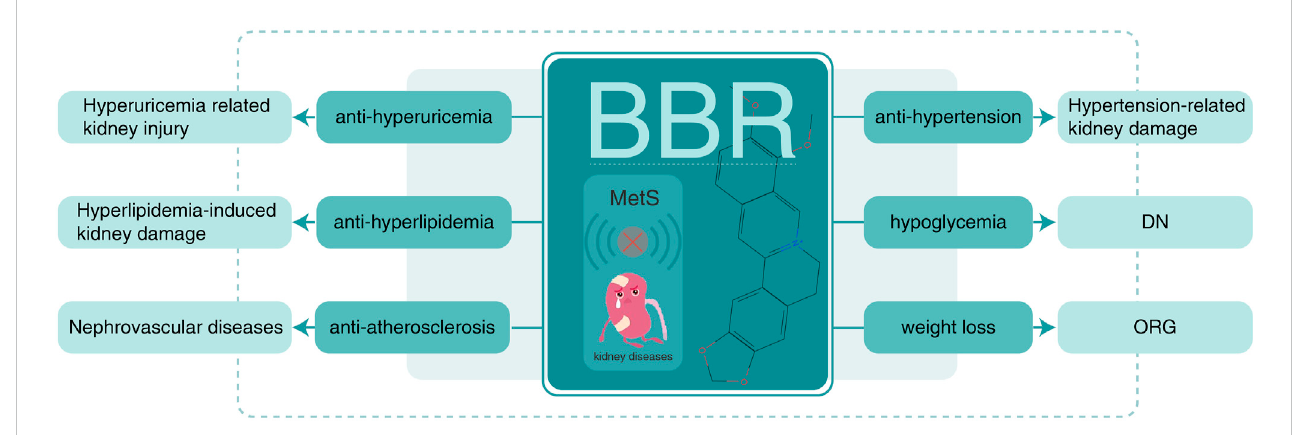
FIGURE 4 BBR on MetS-associated kidney disease. BBR, berberine; MetS, metabolic syndrome; ORG, obesity-related glomerulopathy; DN, diabetic nephropathy.